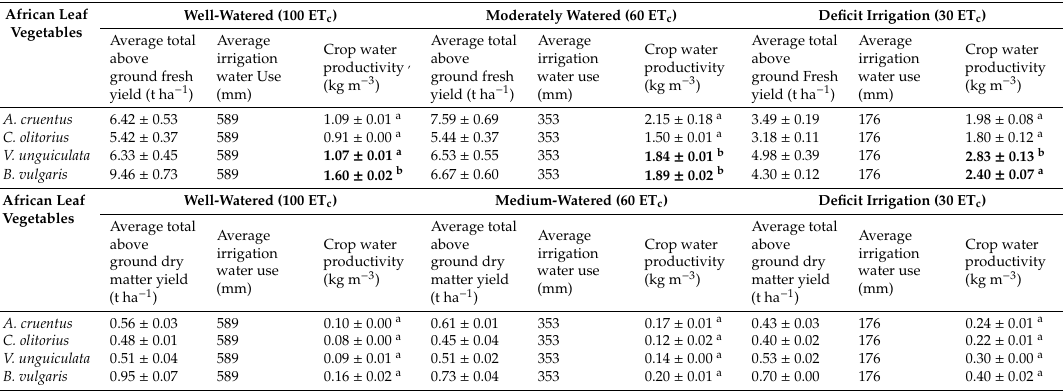
Table 5. Average total above ground fresh mass and dry yield, irrigation water use and crop water productivity of selected African leafy vegetables for two seasons (2015 / 2016 and 2016 / 2017) ( n = 12). AfricanLeaf